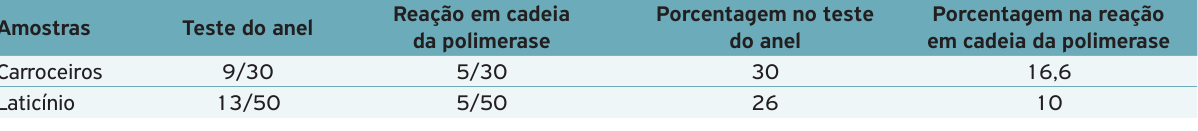
Tabela 1. Relação entre a positividade obtida no teste do anel e na reação em cadeia da polimerase nas amostras de leite coletadas de carroceiros e no laticínio.